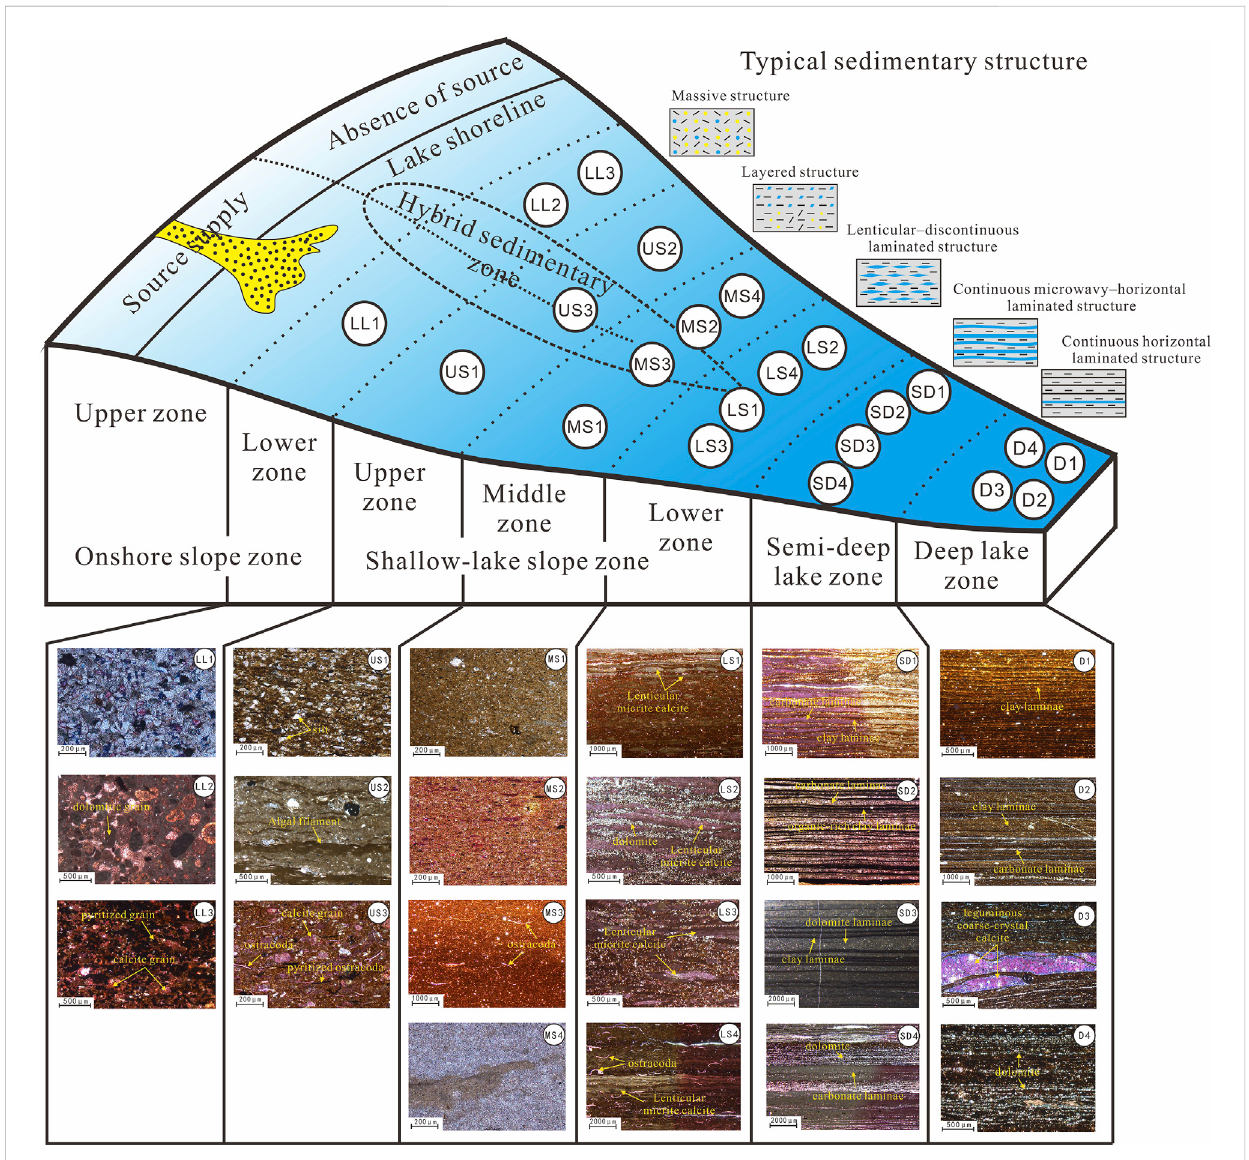
FIGURE 2 Types and distribution of lithofacies in Es 4 u of Boxing